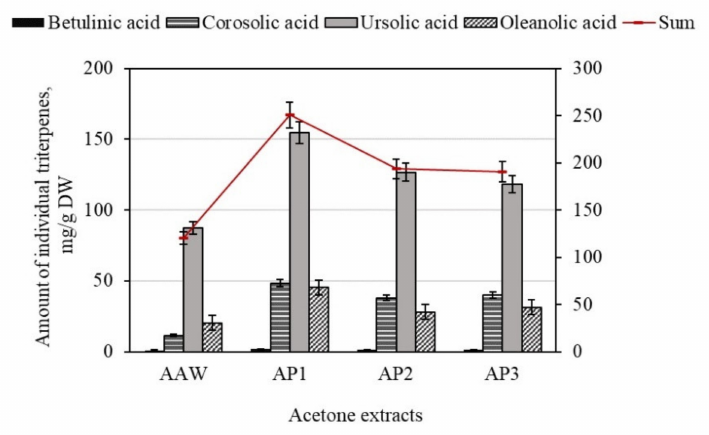
Figure 2. Variation in the quantitative amount of triterpene compounds in the dry acetone extracts of whole apple and apple peel.